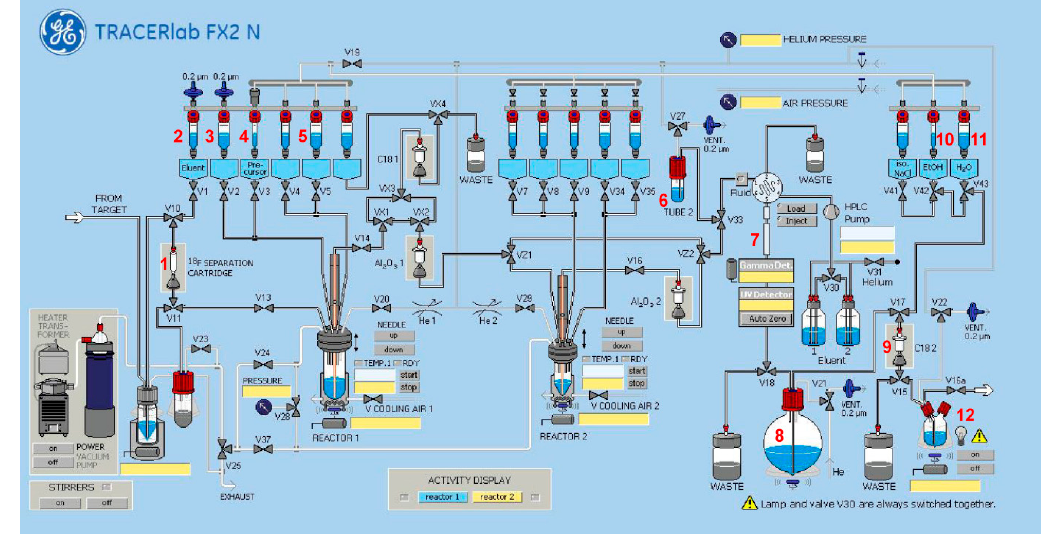
Figure4. Scheme ofthe synthesis moduleTRACERlab FX2 Nfor the radiosynthesisof [ 18 F]9 . (1) Sep-Pak Figure 4. Scheme of the synthesis module TRACERlab FX2 N for the radiosynthesis of [ 18 F]9 . (1) Sep- Accell Plus QMA Carbonate Plus light, (2) K 2 CO 3 (1.8 mg in 400 µ L water), (3) K 2.2.2. (11 mg in 1.5 mL Pak Accell Plus QMA Carbonate Plus light, (2) K 2 CO 3 (1.8 mg in 400 µL water), (3) K 2.2.2. (11 mg in 1.5 ACN), (4) precursor (0.5 mg of 10 in 800 µ L DMSO), (5) 1.5 mL water and 2.0 mL MeOH /